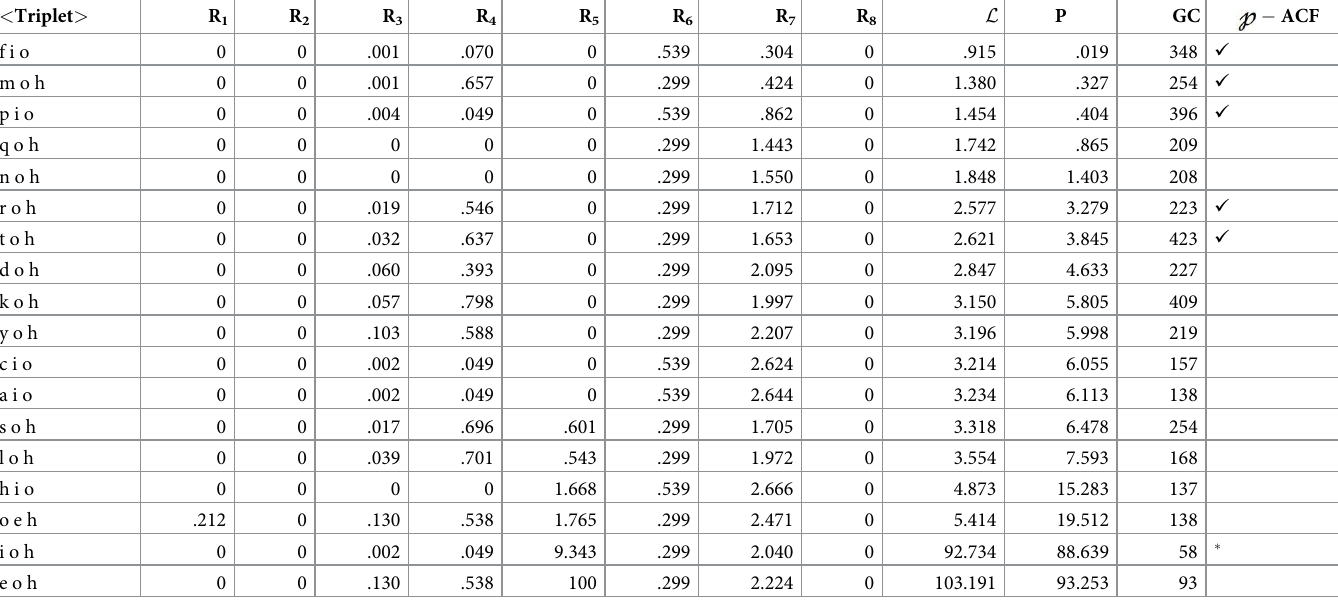
Table 5. Enumeration of the best ligature candidates and their components.